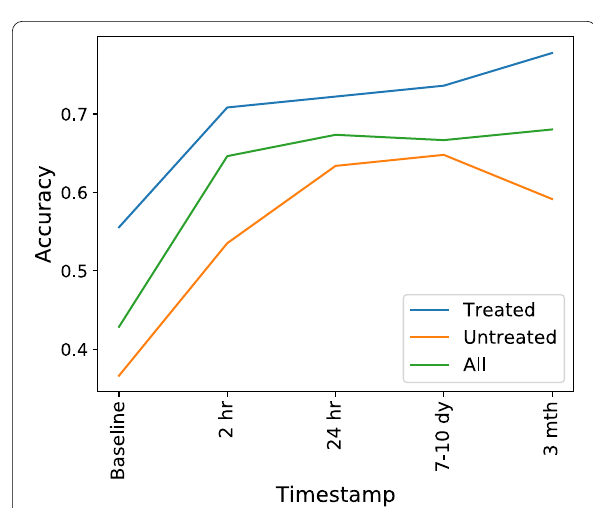
Fig. 5 Test accuracy denoting predictive power of a graph neural network as a function of timepoint. Accuracy plotted separately for patients that received tPA treatment, placebo patients and all patients (tPA treated placebo). 70% data used for training the neural + network, 30% for testing. Number of training epochs 100. We use a = 2 layer graph convolutional neural network with 16 hidden units